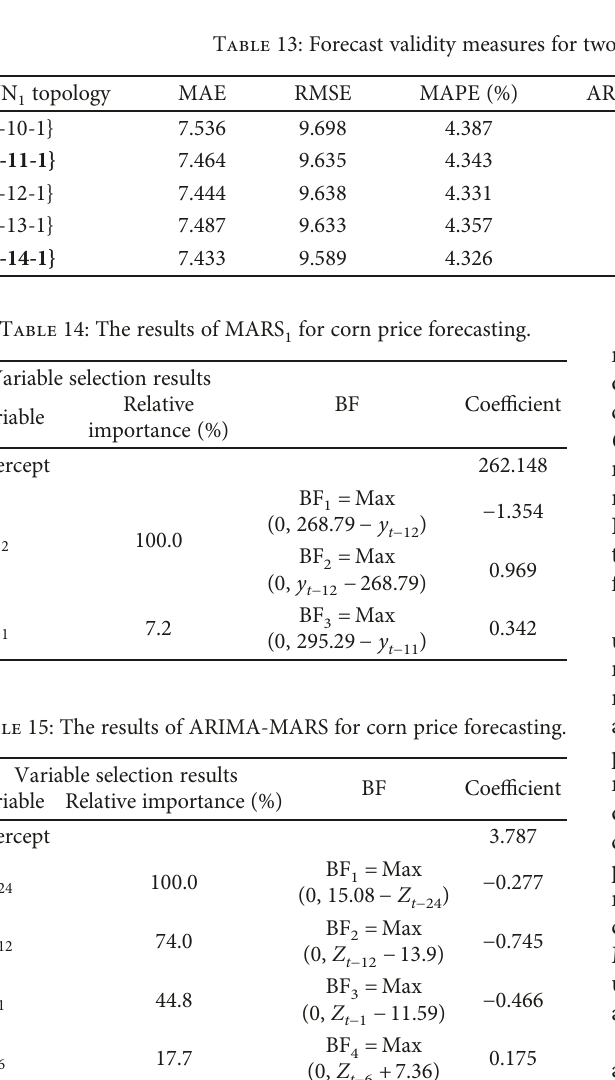
Table 13: Forecast validity measures for two ANN designs (corn price forecasting).